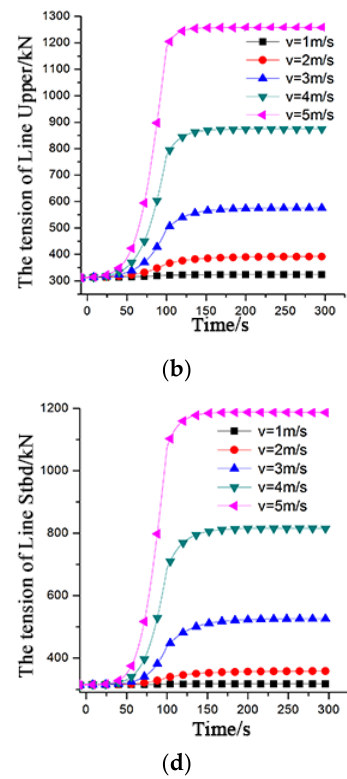
Figure 12. The time domain image of cables tension of the rigid truss trawl system in straight-line towing: ( a ) Line Lower; ( b ) Line Upper; ( c ) Line Port; ( d ) Line Stbd.